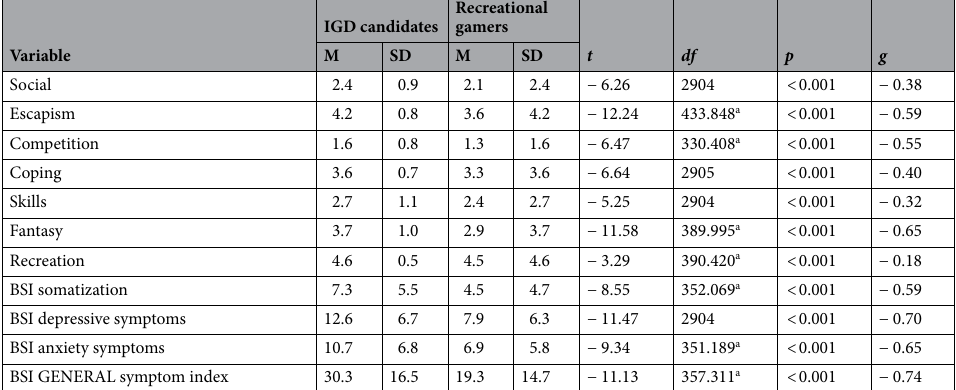
Table 4. Group differences in gaming motivations (MOGQ) as well as in psychopathological symptoms (BSI- 18). BSI Brief Symptom Index (Ref). a Welch’s test is reported due to variance inhomogeneity and the degrees of freedom corrected